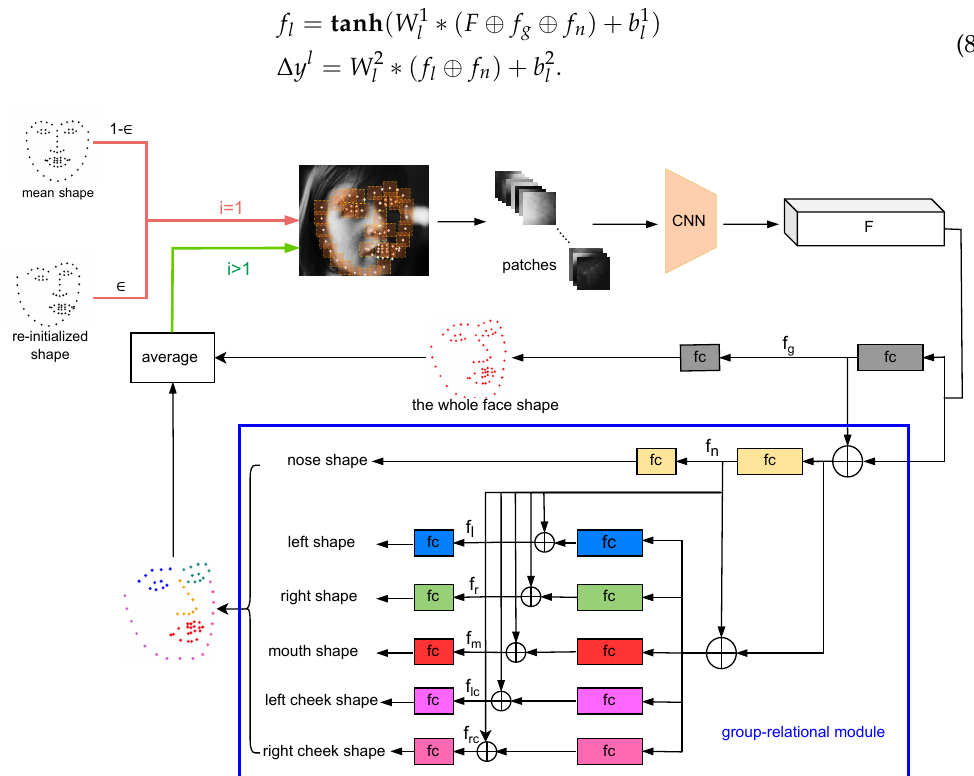
Figure 5. Illustration of a dense landmark detection network that exploits a group-relational module to reason the relations between facial groups. The mean shape and the reinitialized shape are used as candidates for initialization. ⊕ is the concatenation